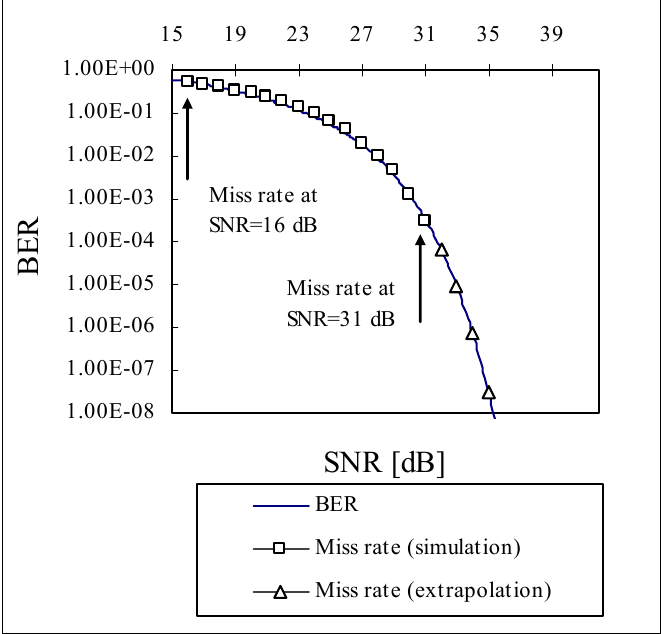
Figure 10 . Extrapolation of miss rate on BER curve.